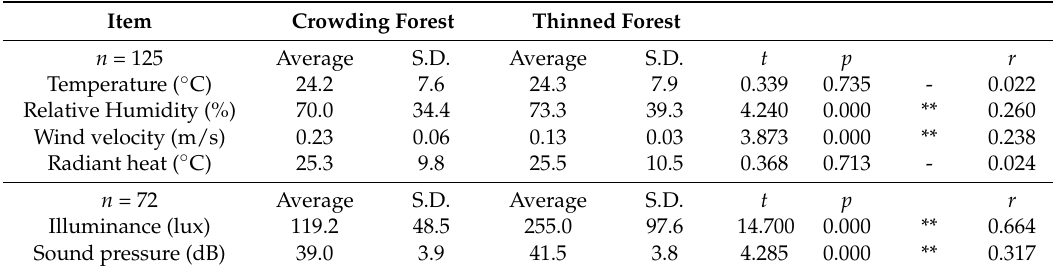
Table 4. T -test results for the comparisons of the physical features of the crowding and thinned forests. Item Crowding Forest Thinned Forest